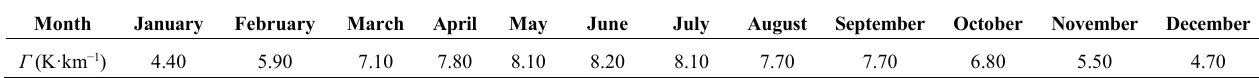
Table 4. Air temperature lapse rate ( Γ ) variations for each month of the year in the Northern